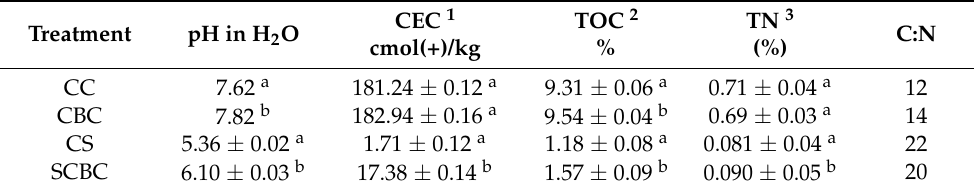
Table 4. Effects of biochar and compost mix application on soil chemical properties after 8 weeks of